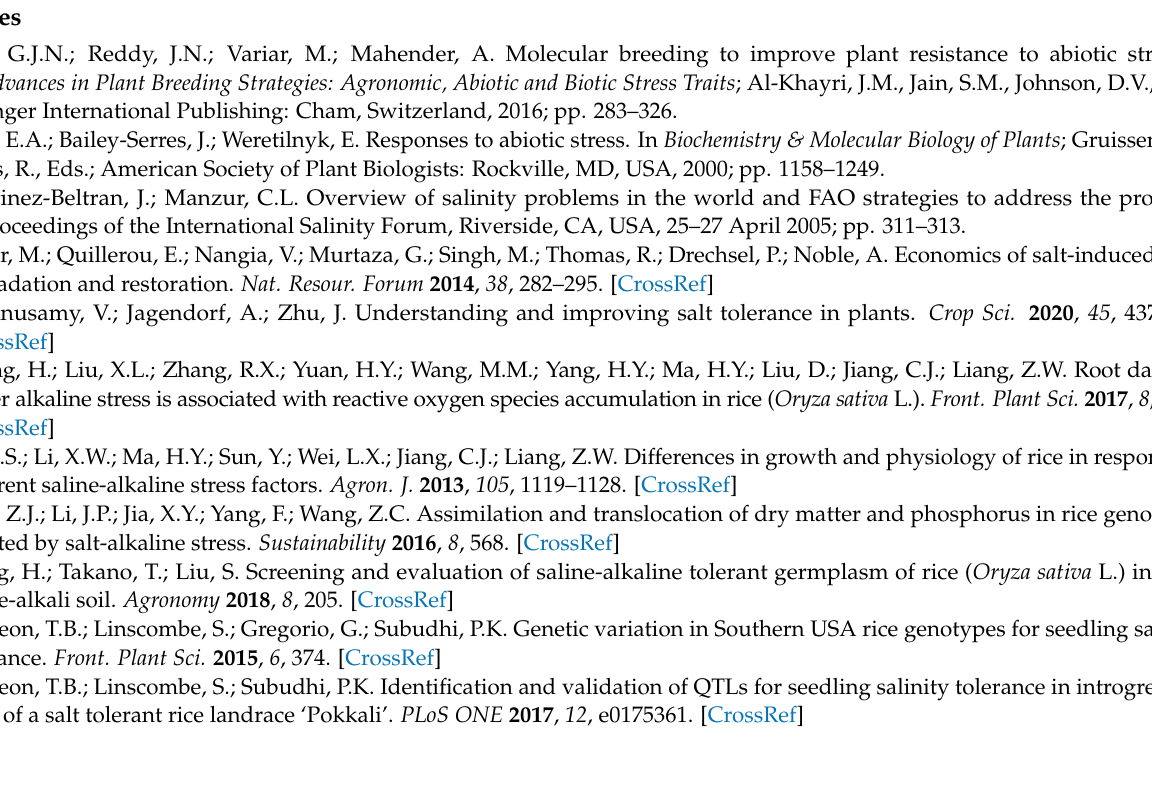
Table S8: List of primers used for gene expression by